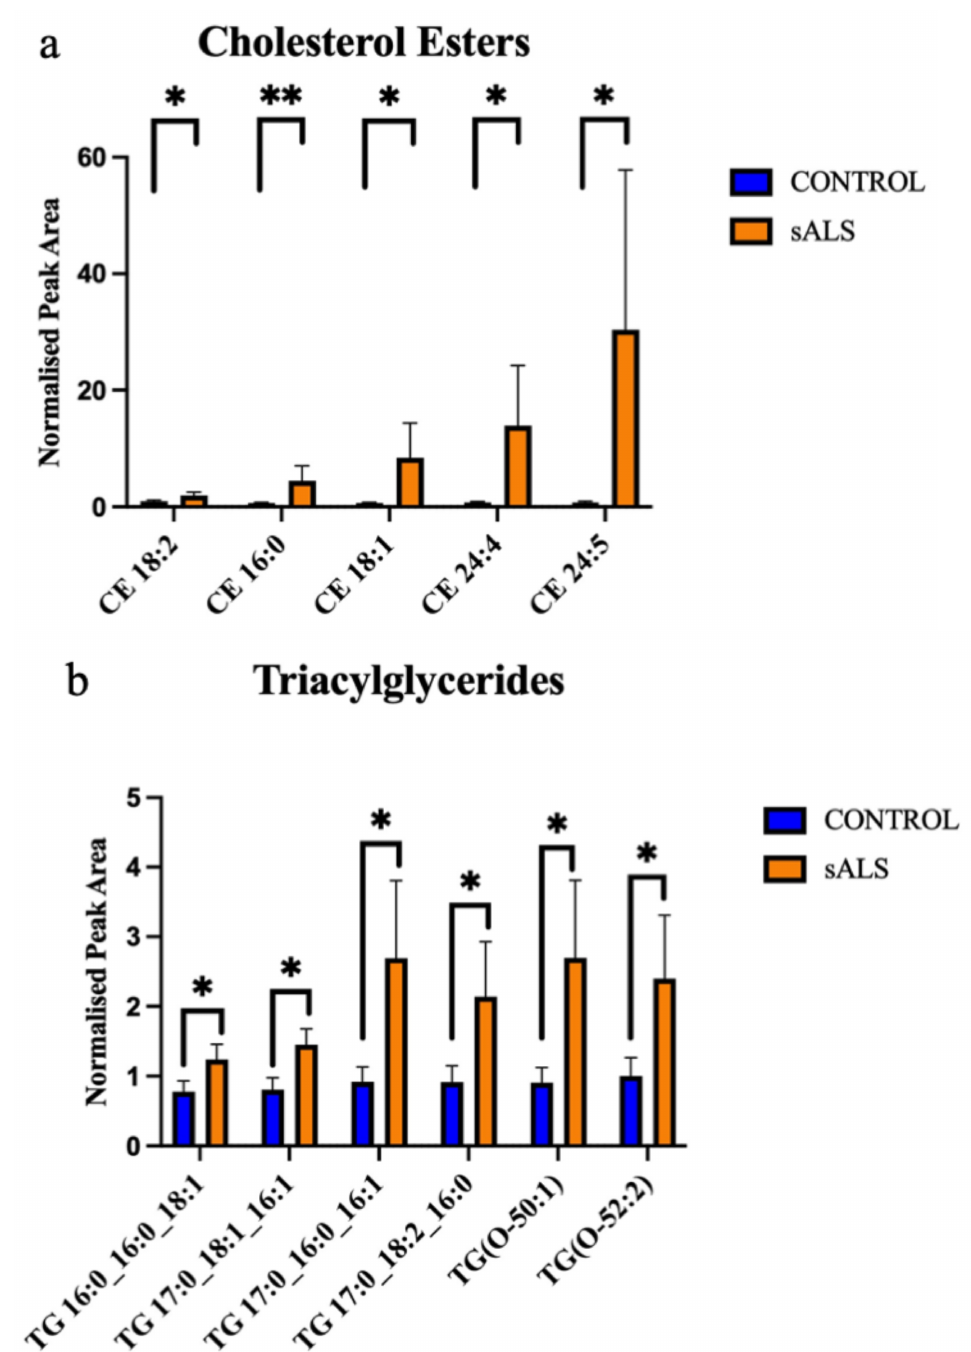
Figure 2. Cholesterol esters and triacylglycerides are increased in ALS compared to control in the motor cortex white matter. ( a ) Cholesterol esters (CE) that have a significantly increased normalised peak area in ALS (orange; sALS n = 8) compared to control (blue; n = 8); ( b ) triacylglycerides (TG) that have a significantly increased normalised peak area in ALS (orange; sALS n = 8) compared to control (blue; n = 8). * p < 0.05; ** p <